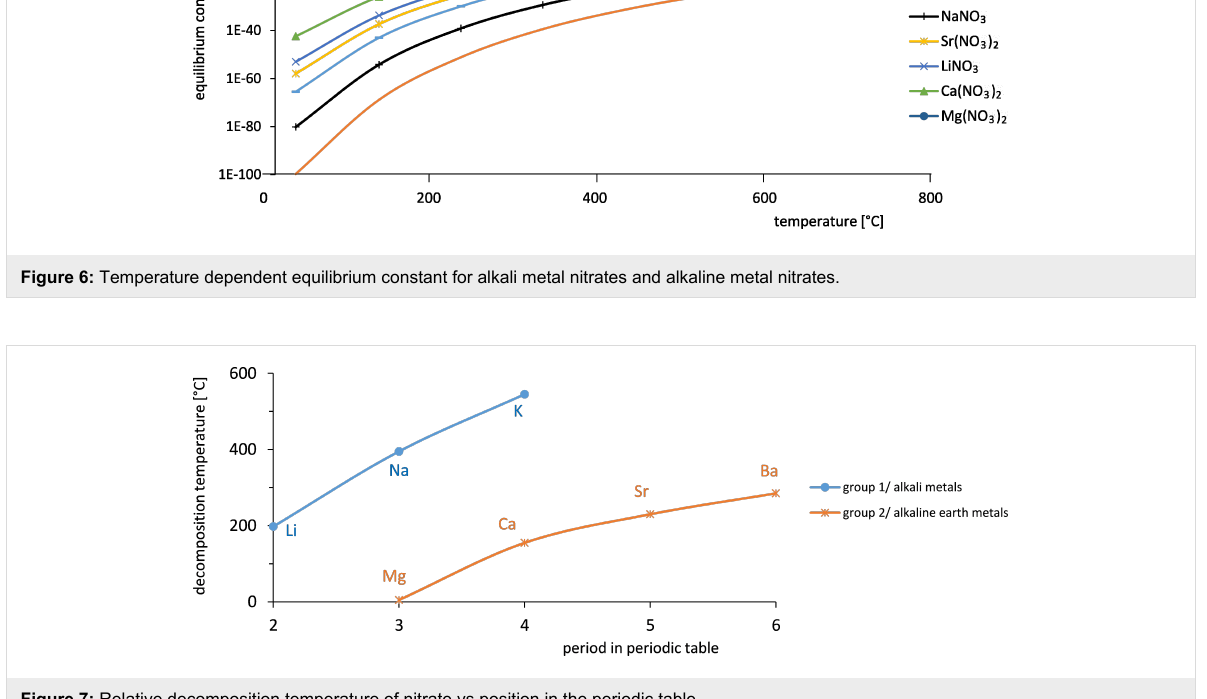
Figure 7: Relative decomposition temperature of nitrate vs position in the periodic